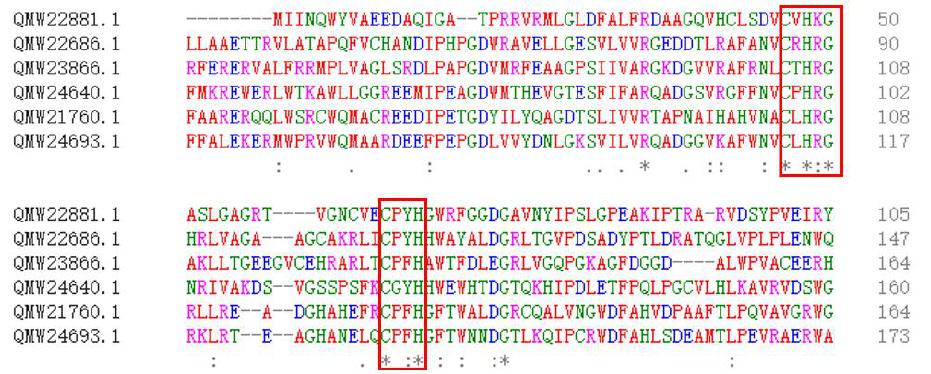
Figure 7. Amino acid sequence alignment of the six ARHDs showing the consensus pattern: C-x-H-R-[GAR]-x(7,8)-[GEKVI]-[NERAQ]-x(4,5)-C-x-[FY]-H, in which the 2 C’s and the 2 H’s are 2Fe-2S ligands [39]. Asterisks (*) indicate positions which have a single, fully conserved residue, a: (colon) indicates conservation between groups of strongly similar properties, a. (period) indicates conservation between groups of weakly similar properties.